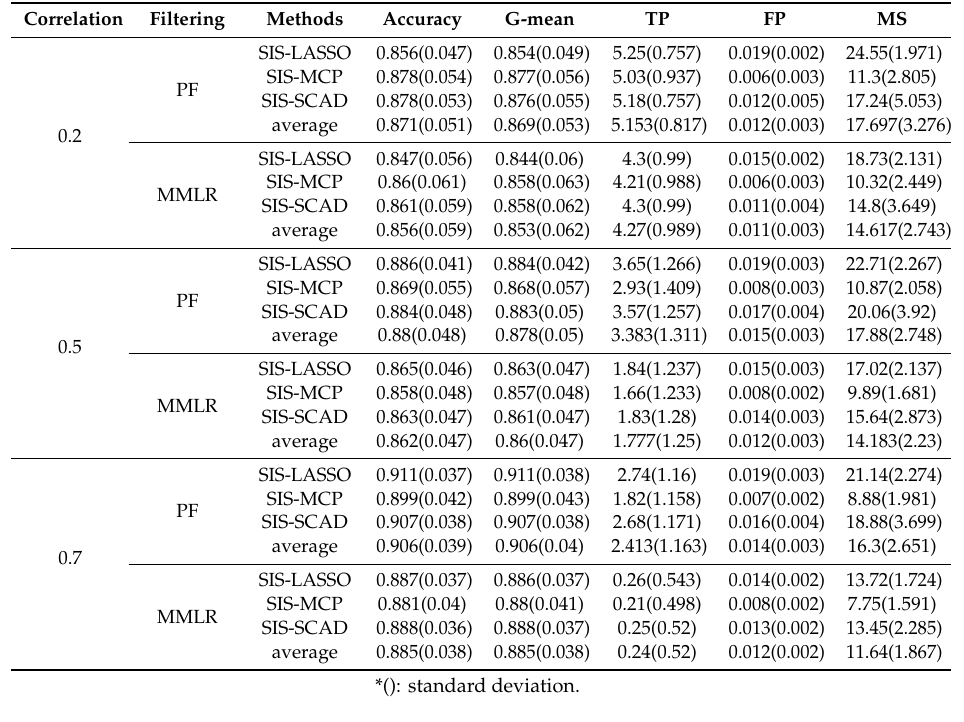
Table 2. Classification performance of proposed filtering (PF) compared to marginal maximum likelihood logistic regression estimator (MMLR) with SIS-LASSO, SIS-MCP, and SIS-SCAD over 100 iterations.